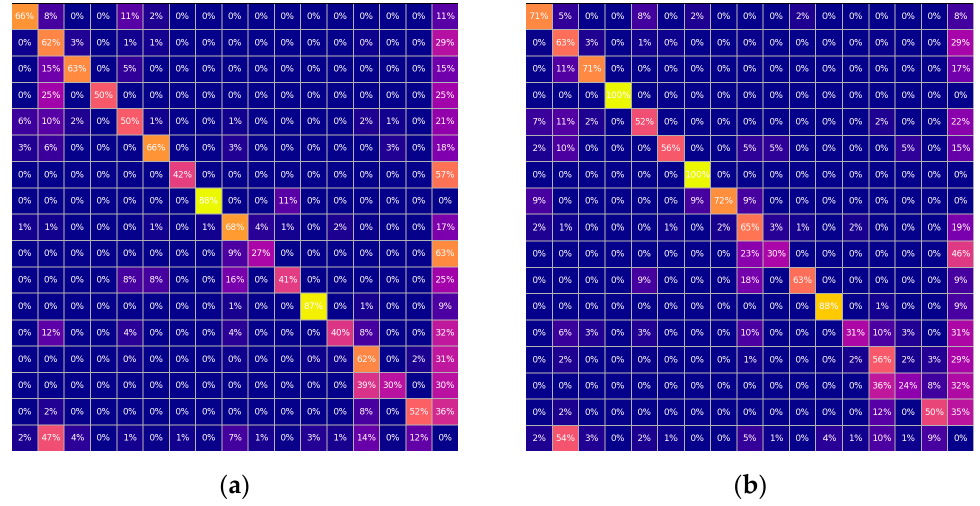
Figure 7. Visualization of the results by confusion matrixes of Oriented-RCNN and our method. The horizontal axis corresponds to the predicted label and the vertical axis corresponds to the ground-truth label, respectively. Rows or columns 1 to 17 correspond to ore-oil, Container, Fishing, LawEnforce, Dredger, Cell-Container, Type1-10, and background, respectively. ( a ) The confusion matrix of Oriented-RCNN. ( b ) The confusion matrix of SPG-OSD.